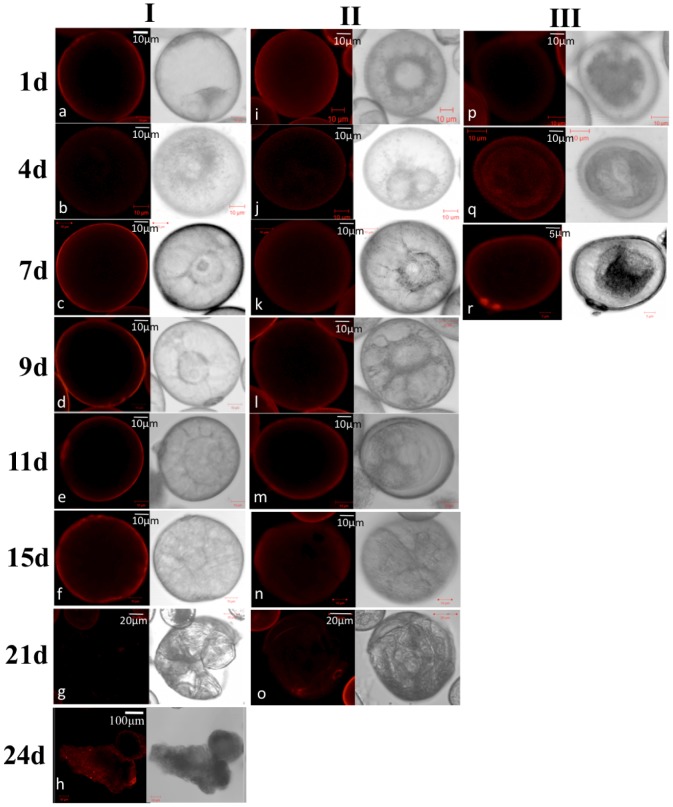
Developmental pathways of pre-treated wheat microspores in culture, as determined by time-lapse tracking.According to the type of development, microspores are grouped into three classes: type I (A–H), type II (I–O) and type III (P–R). Microspores were stained with FM 4–64 (Molecular Probes Cat. # T-3166) to confirm their viability in culture. All pictures were taken at a 25× magnification and 6× optical zoom except for G, O and H, where the former two pictures were taken at the same magnification but at 3× optical zoom and the latter picture was taken at 10× magnification and 1.7× optical zoom.